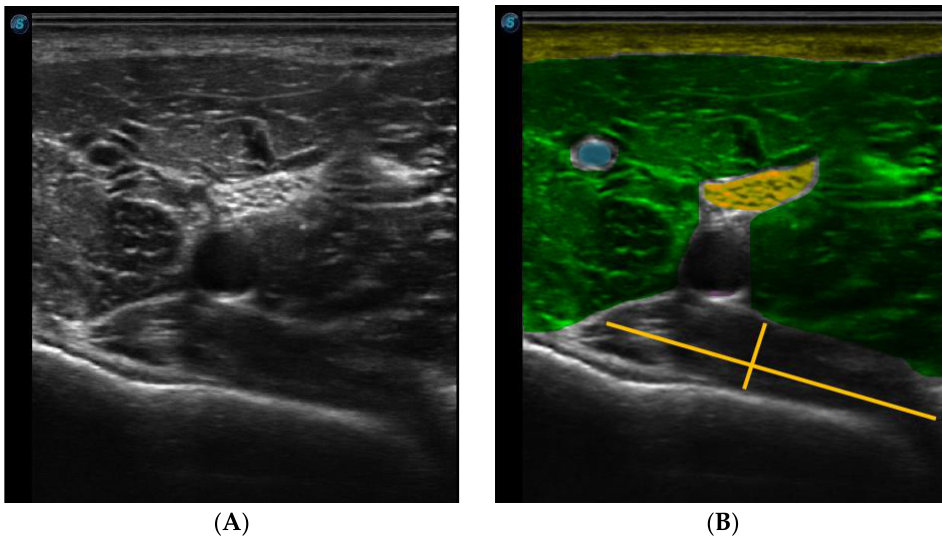
Figure 3. Ultrasound image of the popliteal region. ( A ) Ultrasound B-mode image ( B ) Colored Ultrasound B-mode image (rose-skin, yellow-fat, green-medialis gastrocnemius, blue-vein, magenta-artery, orange-nerve and red-popliteal muscle).